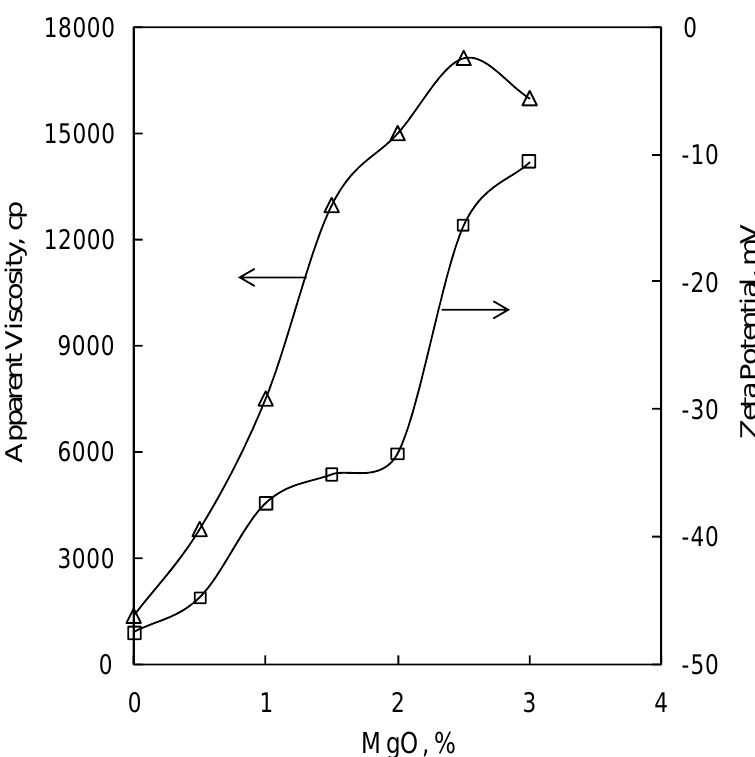
Fig. 3 Dependence of viscosity and zeta potentials on MgO